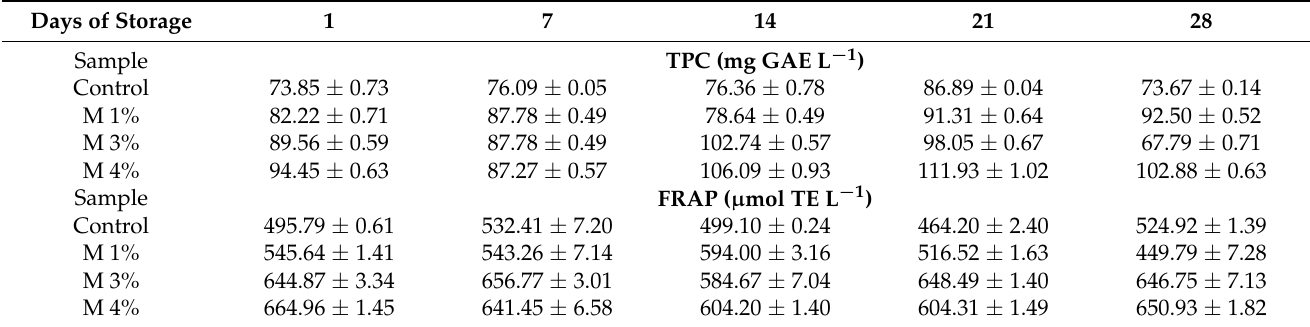
Table 9. TPC and AC (FRAP) in control sample (Control) and samples with moringa extract addition (1, 3 and 4% of extract addition, M 1%, M 3%, M 4%) at the cold storage period.